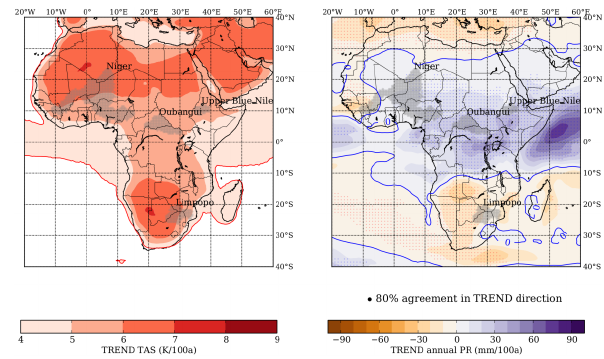
Figure 4 Mean temperature (left) and precipitation (right) trends over the African continent for 2 Fig. 4. Mean temperature (left) and precipitation (right) trends over 19 CMIP5 models from 2006-2100 for RCP 8.5. For precipitation, an agreement in trend 3 the African continent for 19 CMIP5 models from 2006–2100 for direction of 80% or more of the models is marked with a dot. 4 RCP 8.5. For precipitation, an agreement in trend direction of 80% or more of the models is marked with a